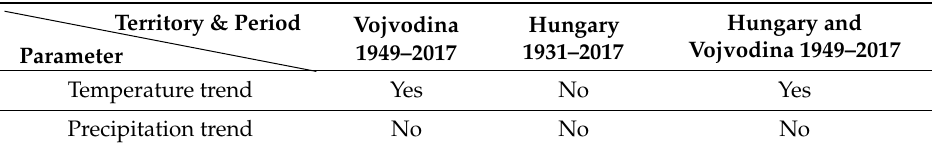
Figure 11. The distributions and trends of the mean annual temperature, Ta , and the mean annual amount precipitation, Pa , for ( A ) Vojvodina during the period 1949–2017, ( B ) Hungary and Vojvodina jointly during the period 1949–2017, ( C ) Hungary during the period 1931–2017, and ( D ) Hungary during the period 1949–2017, respectively. Trends of the Ta and the Pa are presented with solid, black lines and trend equations, and p are probabilities. Table 3. Summary results of Mann-Kendall (MK) tests for temperature and precipitation trends for Vojvodina in the period 1949–2017, Hungary in the period 1931–2017; and Hungary and Vojvodina jointly in the period